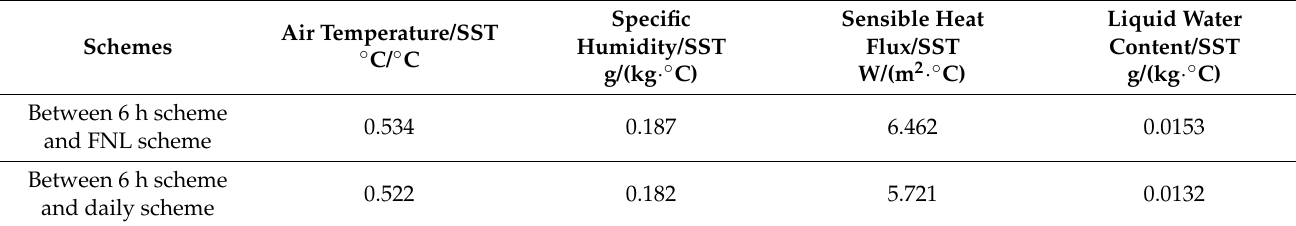
Table 2. Ratio of the sum of absolute differences of meteorological elements to the sum of the absolute differences of SST in the Yellow Sea and Bohai Sea at 00:00 UTC on 20 February 2020.